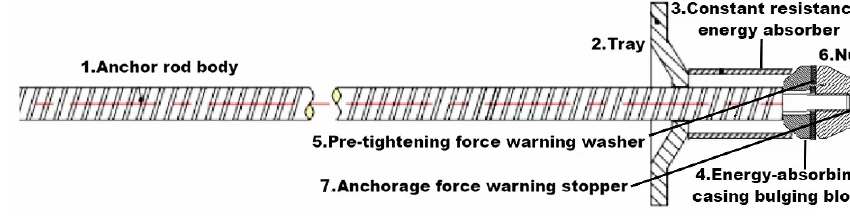
Figure 1. Energy absorbing anchor structure diagram.